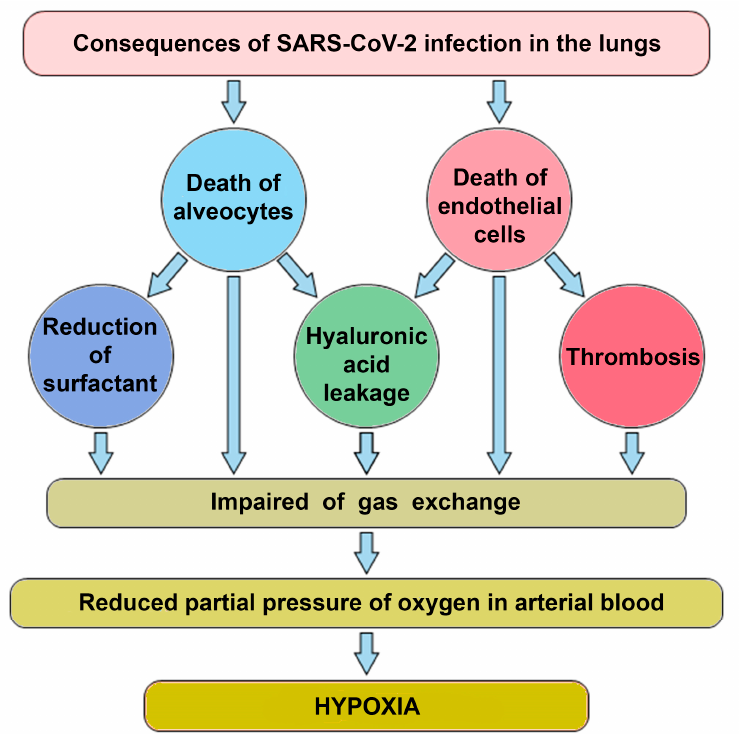
Figure 1. A diagram illustrating the relationship between viral lung damage and the occurrence of hypoxia.